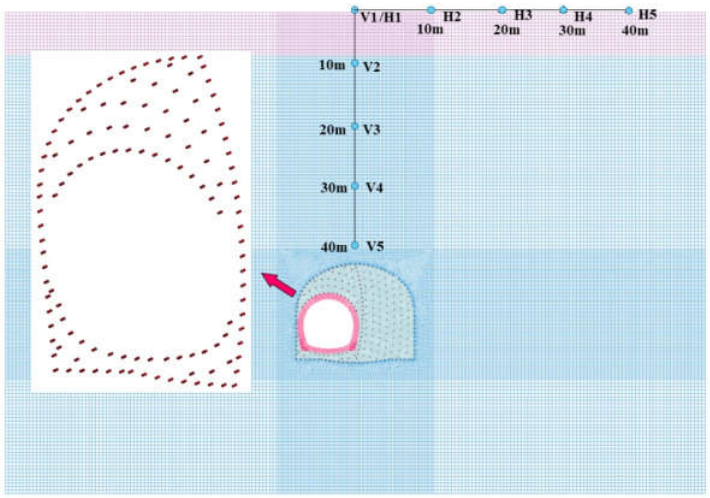
Figure 4. Numerical model of subway station using the CD excavation method.